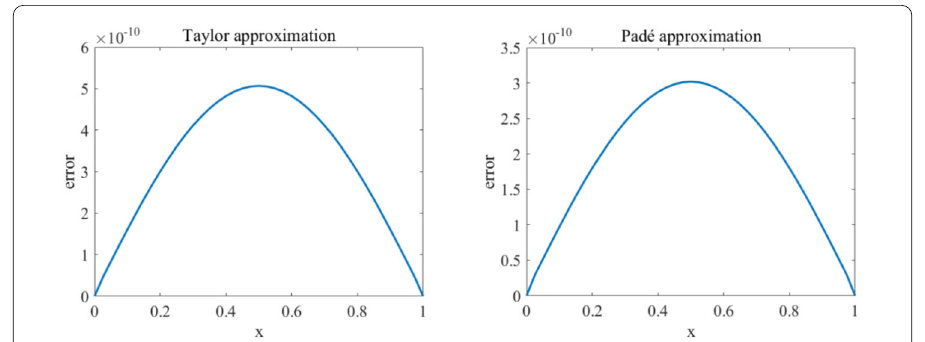
Figure 6 The errors between the exact solutions and CFDS-PIM approximated solutions of the Taylor approximation (on left-hand side figure) and the errors between the exact solutions and CFDS-PIM approximated solutions of Padé approximation (on right-hand side figure) at t = 2 for case 1 of Example 1